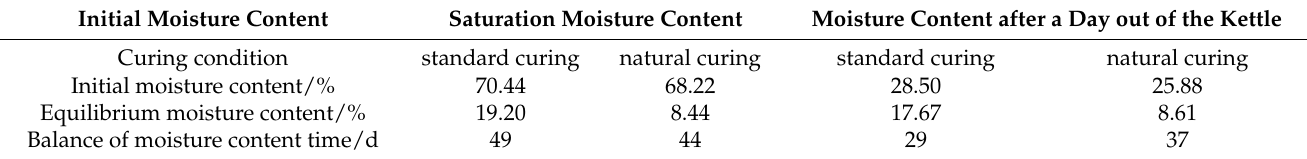
Table 9. Changes of moisture content on different